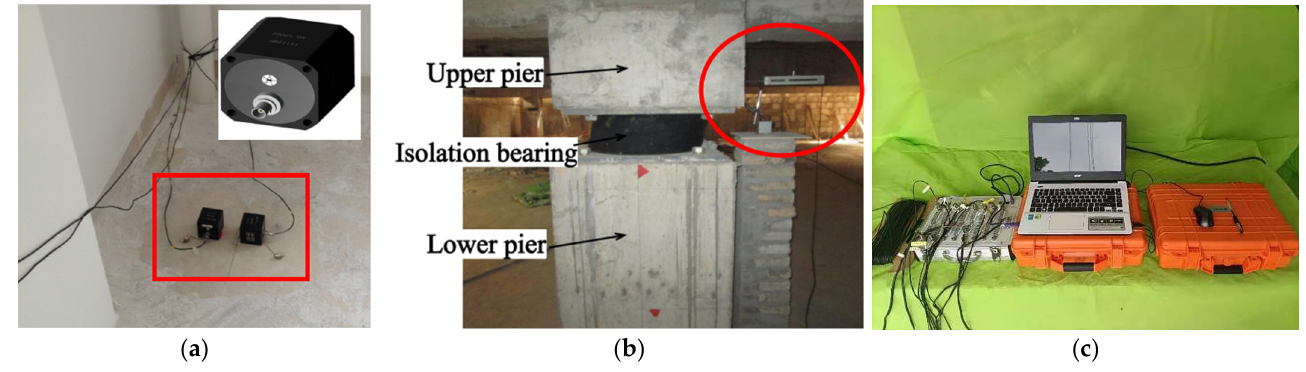
Figure 9. Field testing instruments and related equipments: ( a ) DH612 sensor; ( b ) electric displace- ment meter; ( c ) data acquisition instrument.